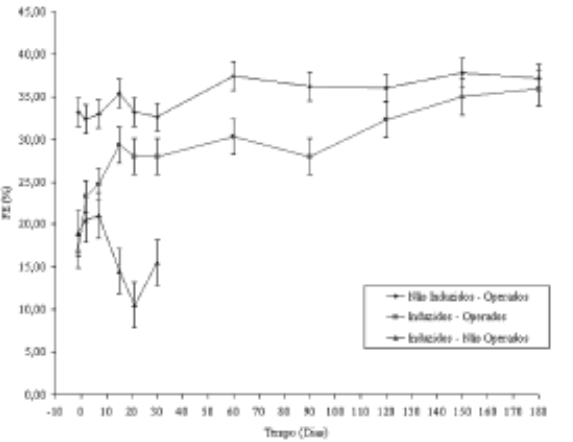
Fig. 2 – Fração de encurtamento do ventrículo esquerdo (FE), ao longo do tempo, de cães hígidos (n = 5) ou com cardiomiopatia dilatada induzida pela doxorrubicina (n = 4), submetidos à plicatura da parede livre do ventrículo esquerdo e cães induzidos não operados (n=2)